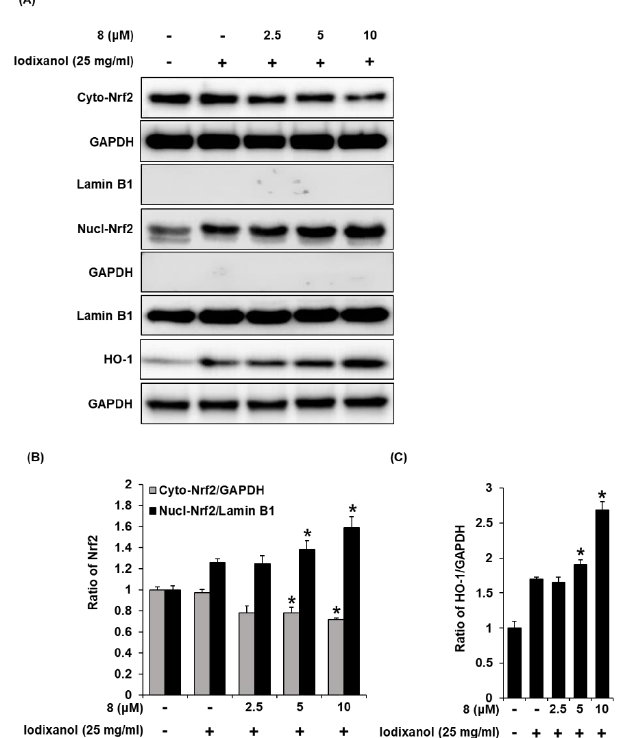
Figure 5. The effect of 3- epi- iso -seco -tanapartholide (compound 8 ) on the nuclear expression of Nrf2 and HO-1 proteins associated with antioxidant pathways in LLC-PK1 cells exposed to iodixanol. ( A ) LLC-PK1 cells were treated with 25 mg/mL iodixanol in the absence or presence of 8 , and western blot analysis was conducted using antibodies for Nrf2, Lamin B1, HO-1, and glyceraldehyde 3-phosphate dehydrogenase (GAPDH). Lamin B1 and GAPDH were used as a cytosolic and nuclear controls for western blot analysis, respectively. ( B and C ) The ratios of nuclear Nrf2, cytosolic Nrf2, and HO-1 compared with untreated cells are represented as a bar graph (mean ± SD, n = 3, * p < 0.05 compared with iodixanol-treated LLC-PK1 cells). Biomolecules 2020 , 10 , x FOR PEER REVIEW